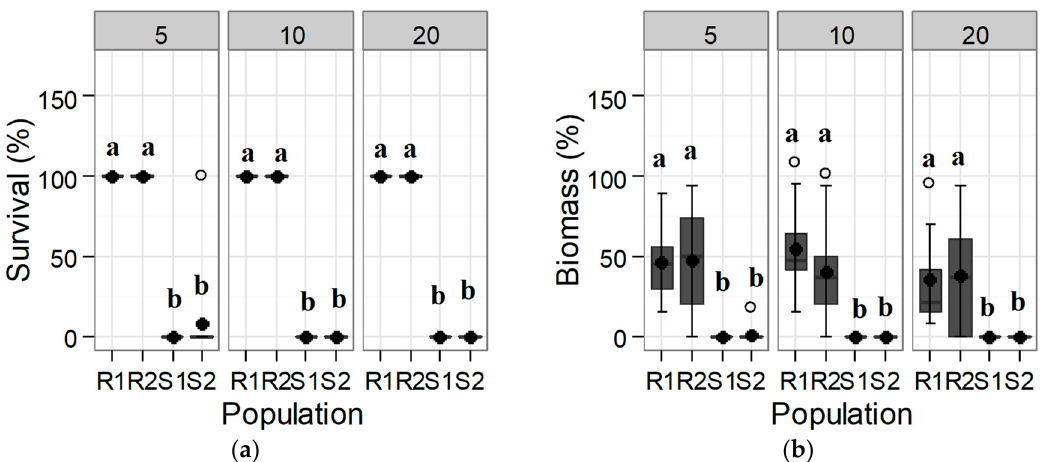
Figure 2. Box-plot showing ( a ) survival and ( b ) biomass for each of the tested Rapistrum rugosum populations compared with those of the untreated control depending on the iodosulfuron-methyl- sodium herbicide rate shown in the upper part of the graphs (in g a.i. ha − 1 ) 30 DAT. Bold points denote means, and white points denote outliers. Populations with different letters for each herbicide rate and for each parameter correspond to statistically significant di ff erences following Tukey’s test ( p < 0.05).